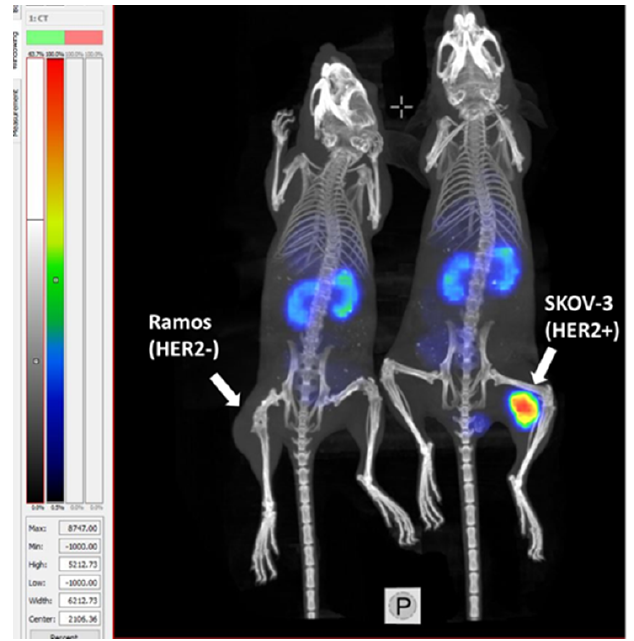
Figure 10. Imaging of HER2-negative Ramos xenograft (left mouse) and HER2-positive SKOV3 xenograft (right mouse) in BALB/C nu/nu mice using [ 99m Tc]Tc- ZHER2:41071. To confirm binding is HER2-specific, one mouse bearing Ramos (HER2-) was used for imaging. Estimated absorbed doses of [ 99m Tc]Tc-ZHER2:41071 in humans are presented in Table 5. According to calculations using OLINDA/EXM 1.0, the effective dose should be